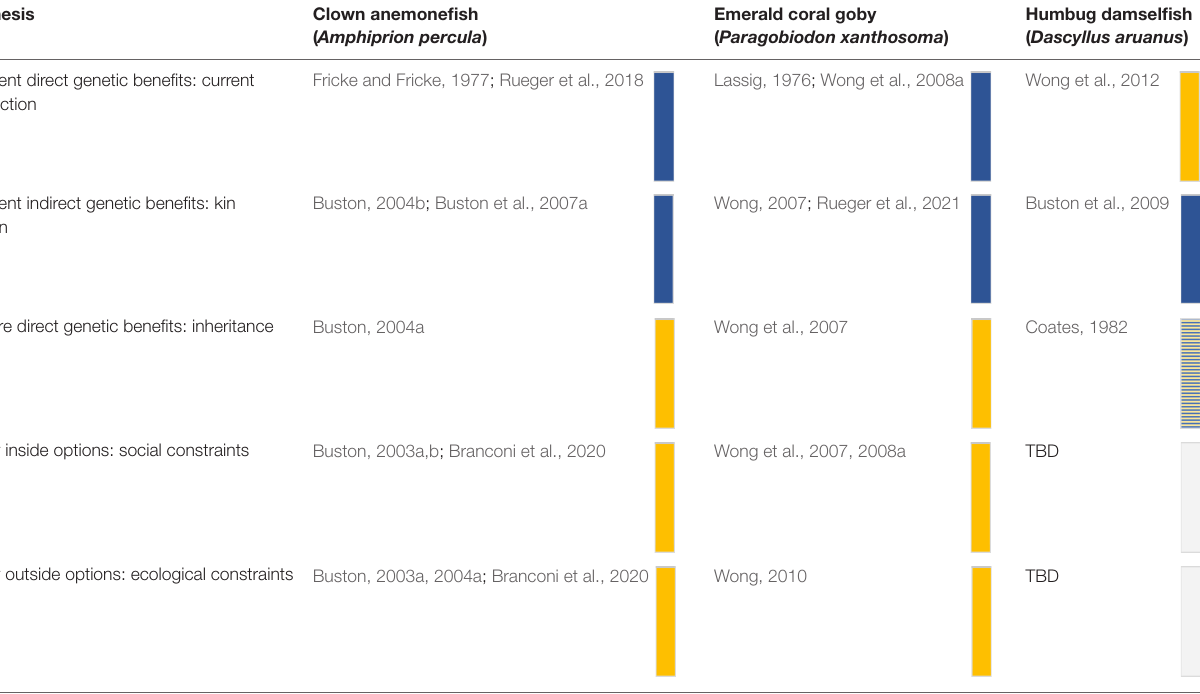
TABLE 1 | Major hypotheses for why non-breeders forgo their own reproduction in three tractable systems within coral reefs: the clown anemonefish, the emerald coral goby and the Humbug damselfish.